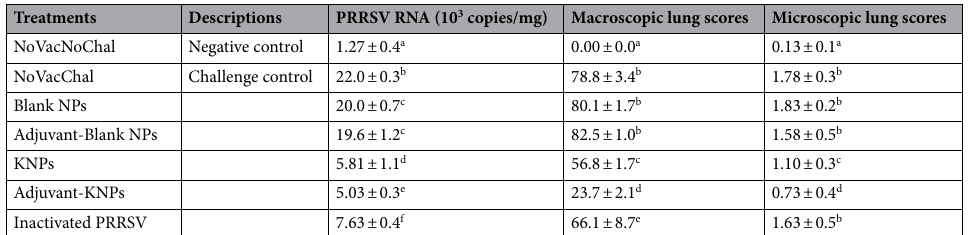
Table 1. Levels of PRRSV RNA in lungs, and macro- and microscopic lung lesions, lung lesions of intranasally vaccinated pigs following challenged with PRRSV-2 at 7 days post challenge. Values are present in mean ± SEM. The difference of lowercase letters exhibited significantly differences between groups ( p < 0.05) in each column.